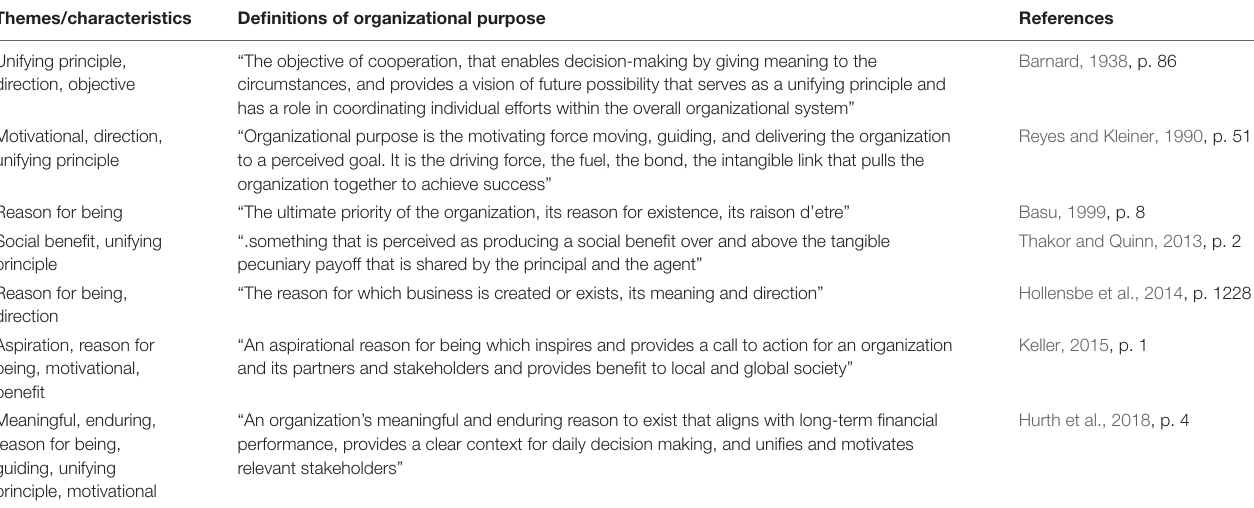
TABLE 1 | A non-exhaustive overview of recurring themes and definitions of organizational